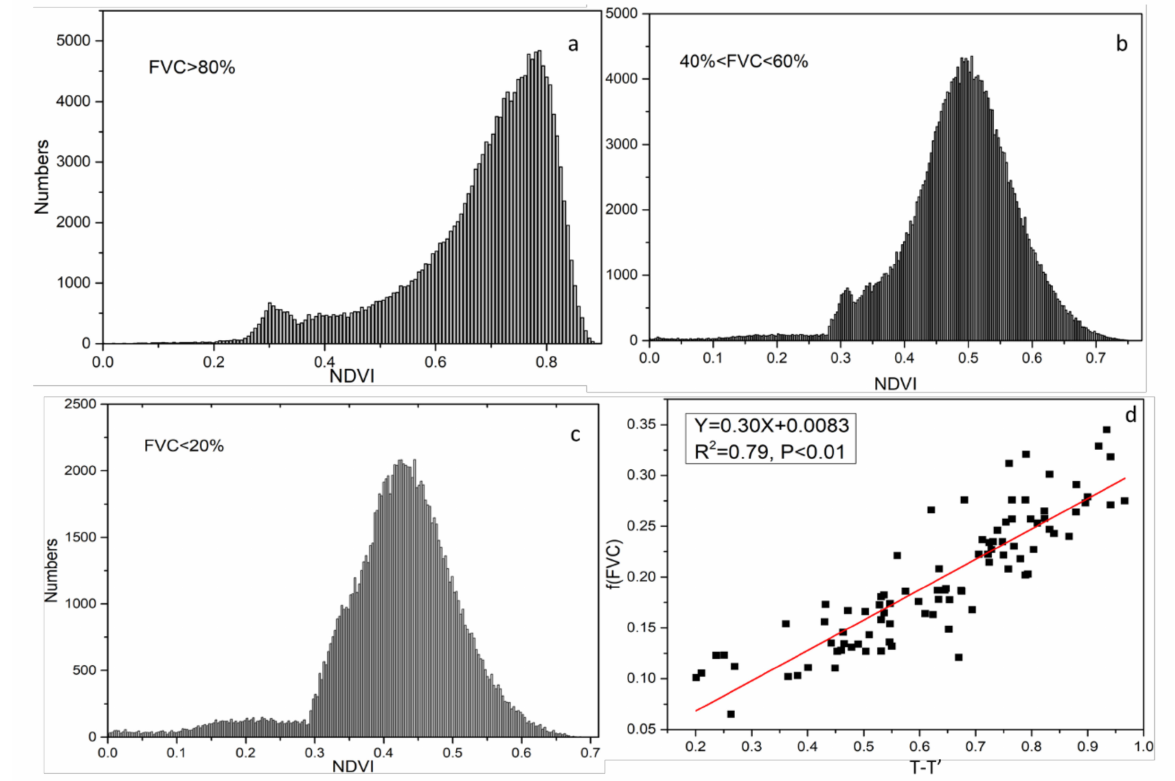
Figure 3. The influence of forest coverage on the shape of gray level histogram. ( a – c) Gray level histograms of the “overall forest coverage”; ( d) linear fit between overall forest coverage (fvc oa ) and